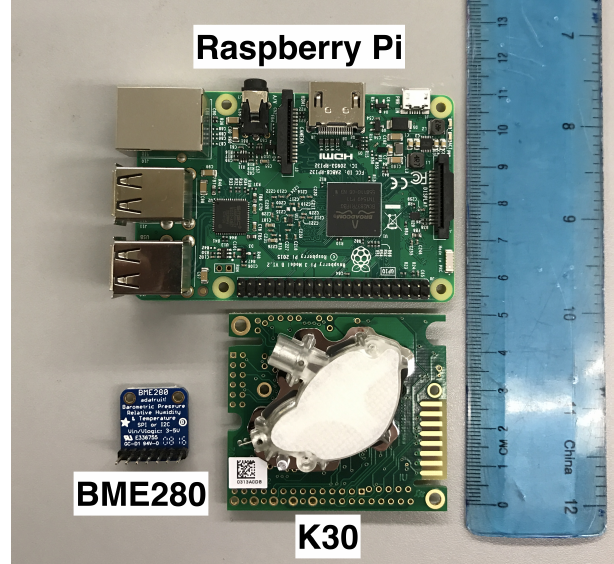
Figure 1. Photograph of a Raspberry Pi computer (top), a SenseAir K30 (NDIR) CO 2 sensor (bottom center), a Bosch BME280 tem- perature and pressure sensor (bottom left) and a ruler for size refer-